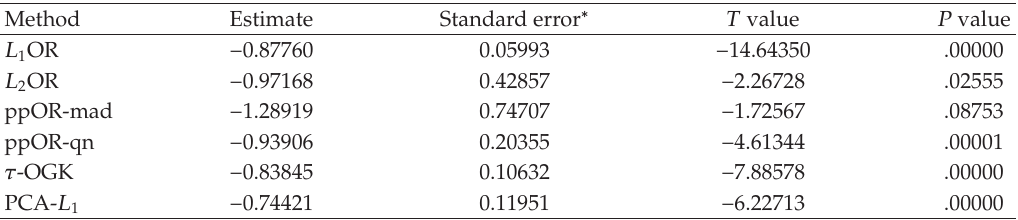
Table 3: Summary of regression models for alkalinity on pH using L 1 OR, L 2 OR, ppOR-mad, ppOR-qn, τ -OGK, and PCA- L 1